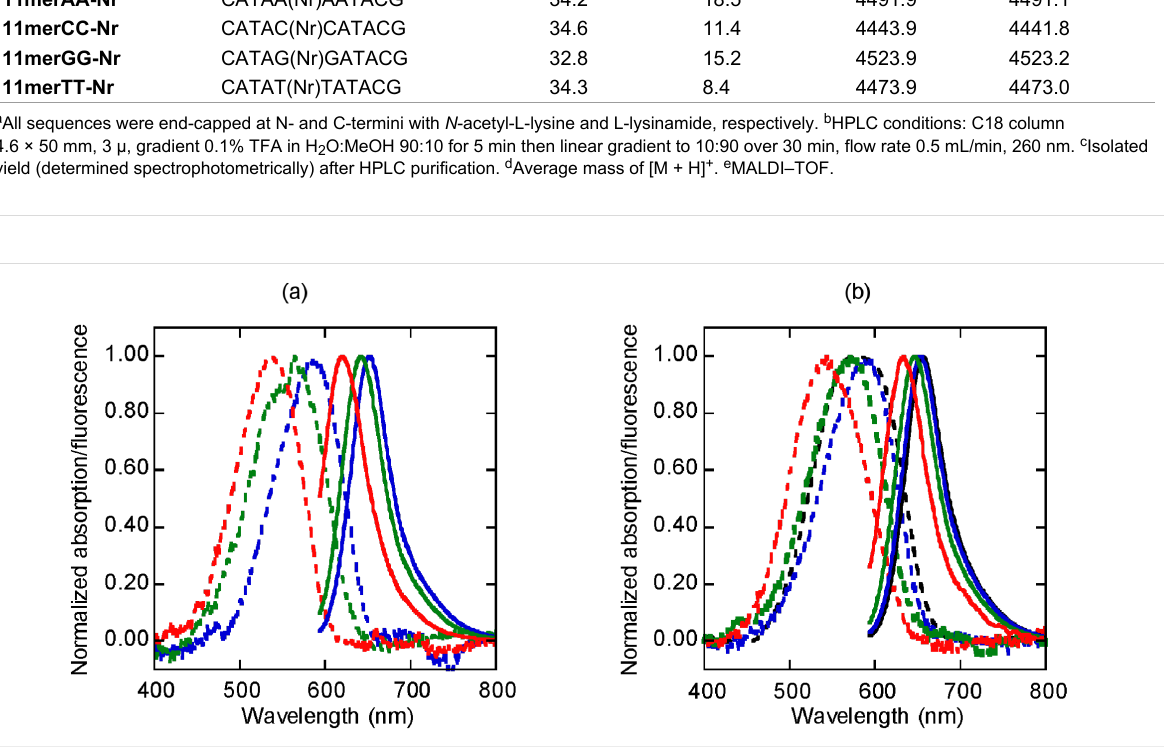
and fluorescence emission maxima in the presence of acetoni- trile (100% MeCN: λ abs 544 nm, λ em 634 nm; 50% MeCN: λ abs 569 nm, λ em 647 nm; 20% MeCN: λ abs 592 nm, λ em 654 nm).